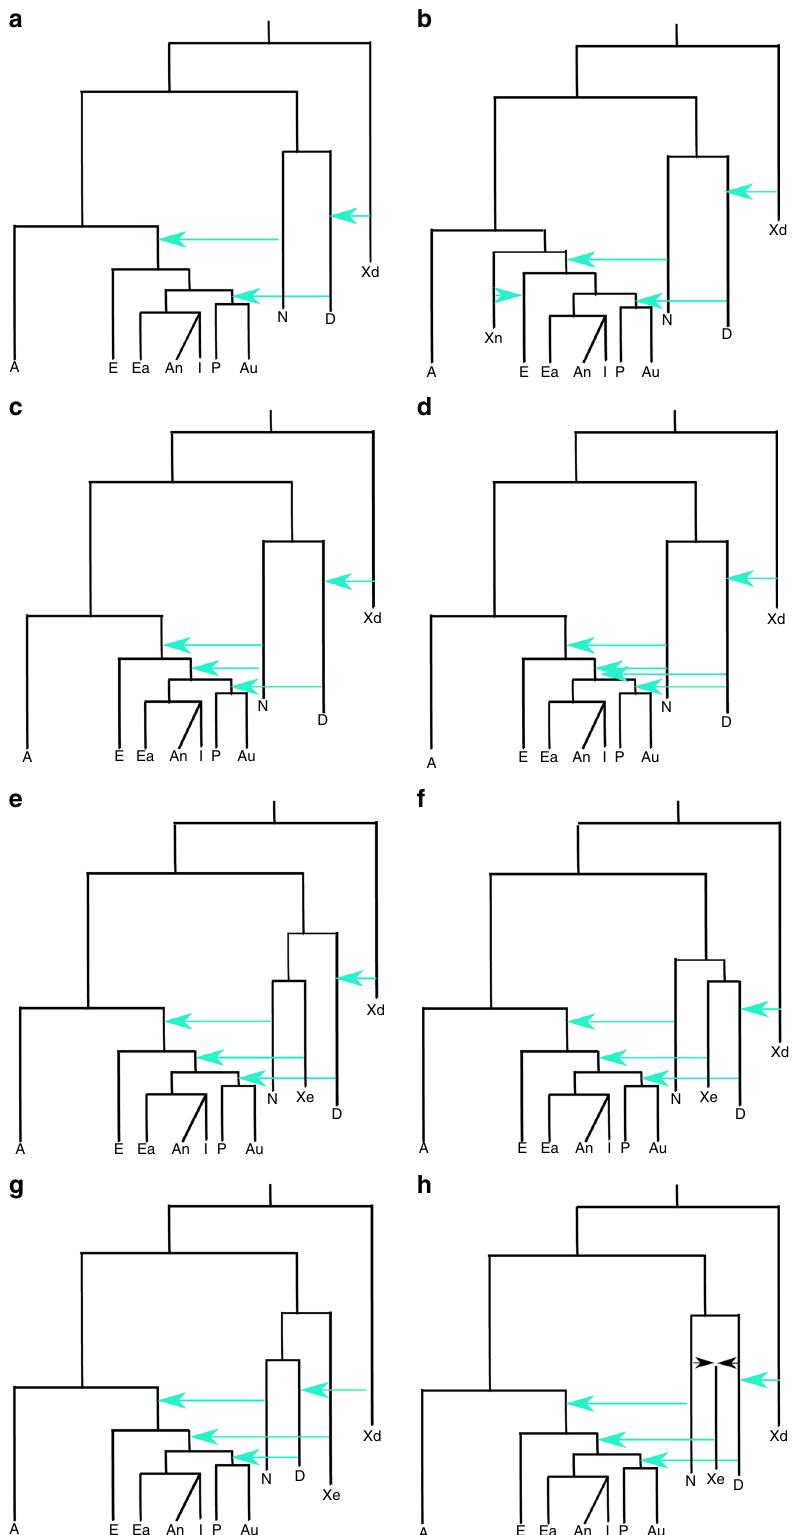
Fig. 2 Demographic models implemented for explaining the genetic variation present in current African (A), European (E), East Asian (Ea), Andamanese (An), Indian (I), Papuan (P) and Australian (Au) populations, in relation with Altai Neanderthal (N) and Denisovan (D) archaic populations. The process of archaic introgression in Asian populations is modelled either by different introgression events from a anatomically modern human ghost population (Xn), b , c , d known archaic populations such as N and D and or e , f , g , h by an unknown archaic extinct (Xe) population. An archaic population (Xd) introgressing to Denisovans is also modelled. Turquoise arrows indicate single pulse events of archaic introgression. All models include recent continuous migrations between African and European, European and East Asian, and Papuan and Australian